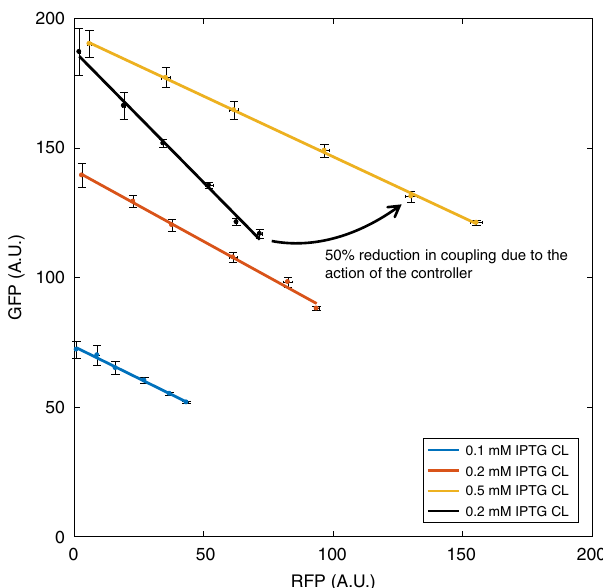
Fig. 7 In vivo implementation of the prototype controller. Response of constitutively expressed o-GFP as o-RFP is induced. o-RFP was induced using AHL from 0 to 20 nM. Points are the mean steady-state fl uorescence ± 1 SD as determined by FACS from cultures during mid-exponential growth (between 3 and 5 h post-induction dependent on the strain and circuit). N = 3. The level of gene expression from the controller can be tuned with IPTG as shown (CL, closed loop). For comparison the o-RFP, o- GFP results which produce comparable initial GFP levels are also shown (OL, open loop). FACS pro fi les are shown in Supplementary Fig. 26. All OL and CL data is shown in Supplementary Fig. 27. Isocost lines are fi t to mean values as described in the ‘ Methods ’ section and gradients shown in Supplementary Fig.